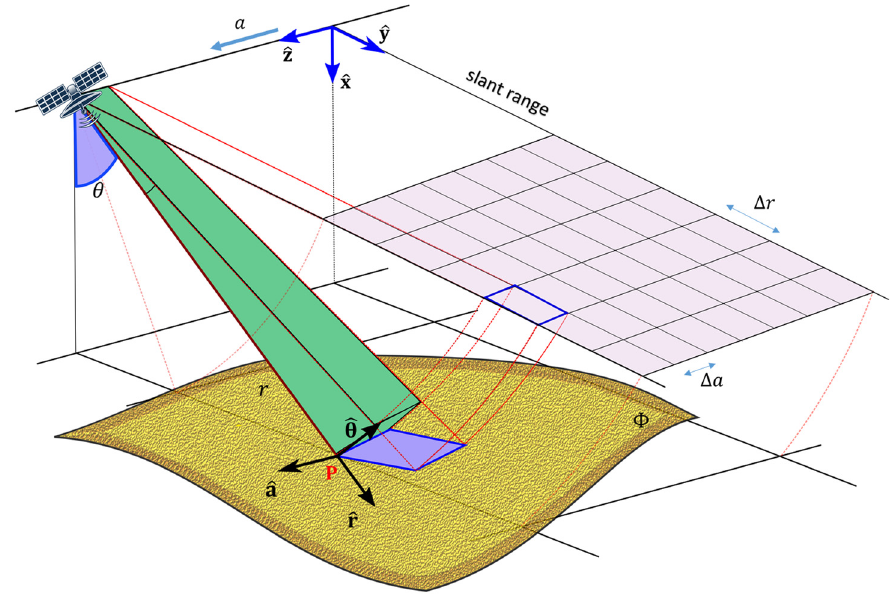
Figure 2. SAR imaging process: geometric scheme.